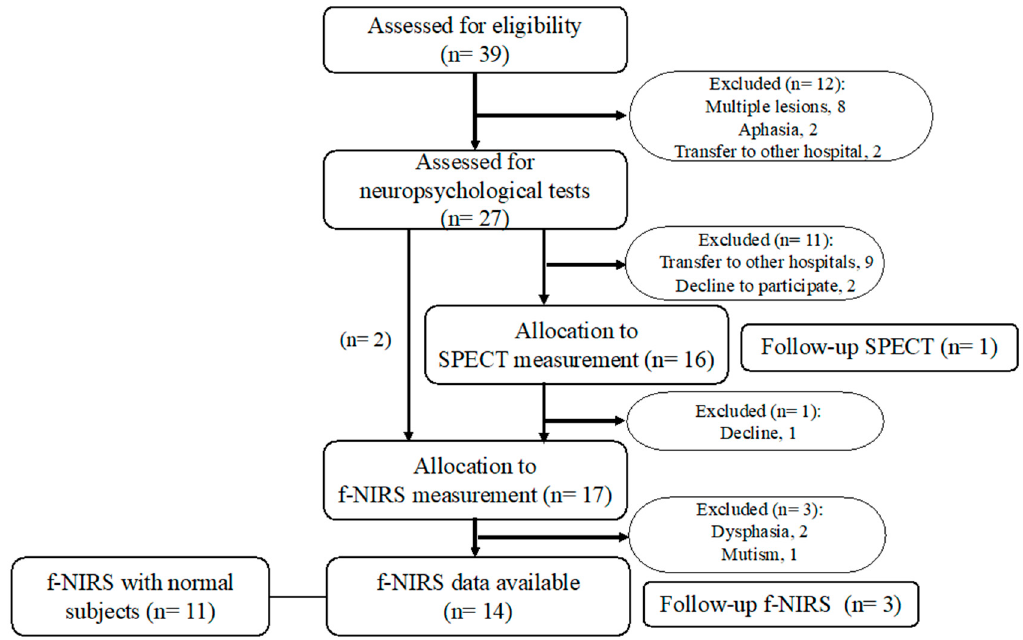
Figure 1. Flowchart showing the study selection process. Note that two patients declined to participate in single-photon emission computed tomography (SPECT), but participated in a NIRS